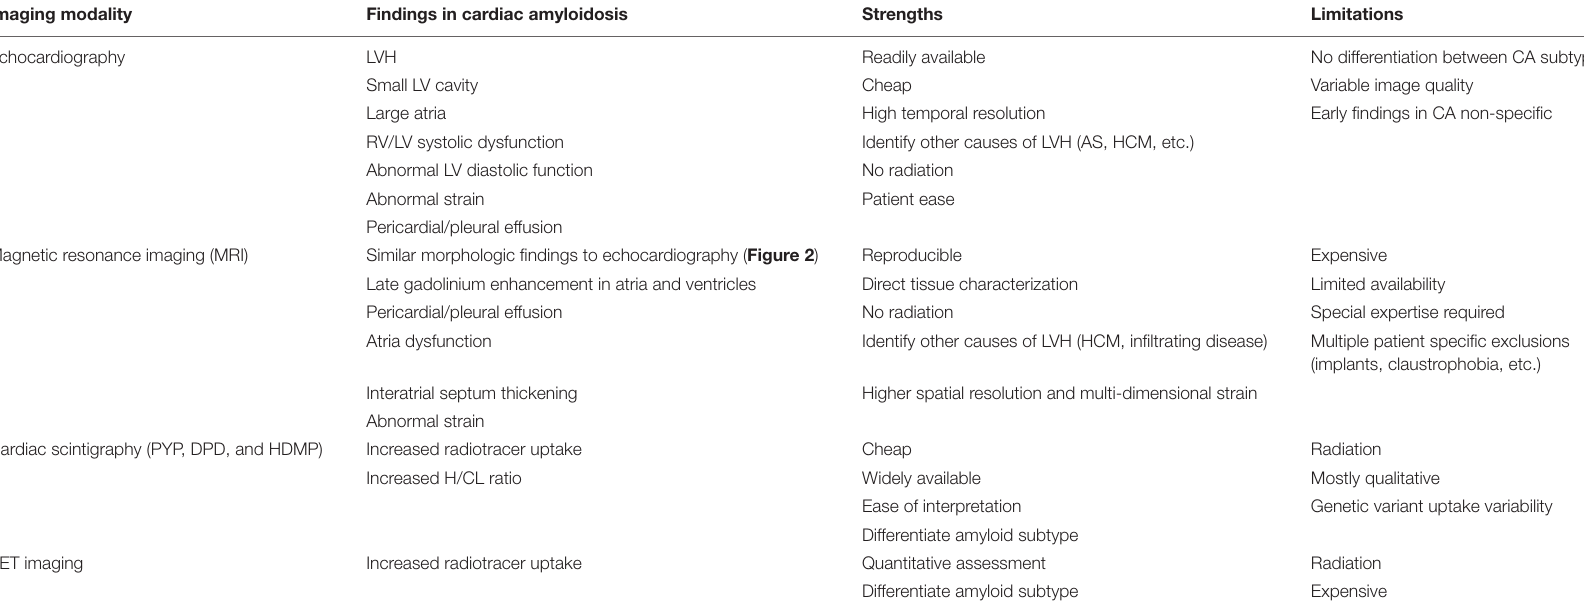
TABLE 2 | Comparison of each imaging modality with their specific findings in cardiac amyloidosis as well as their relative strengths and weakness. Imaging